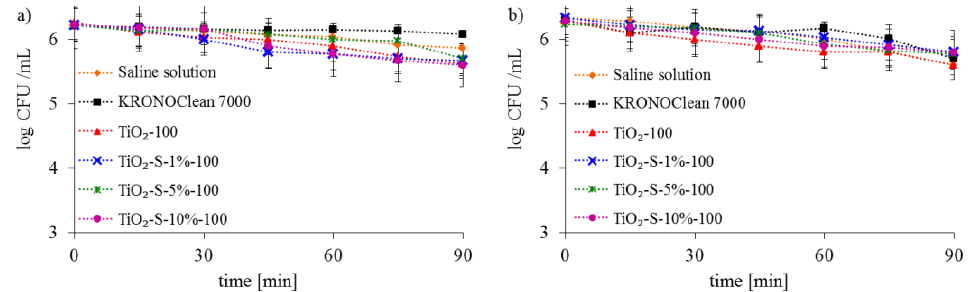
Figure 6. Effects of sucrose-modified titania on inactivation of bacteria in dark conditions: ( a ) Gram- negative E. coli ; ( b ) Gram-positive S. epidermidis .